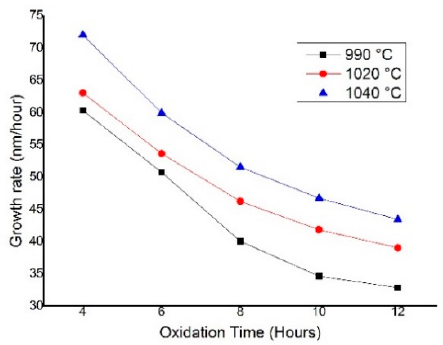
Figure 6. Oxide growth rate of thermal dry oxidation for silicon <100>.